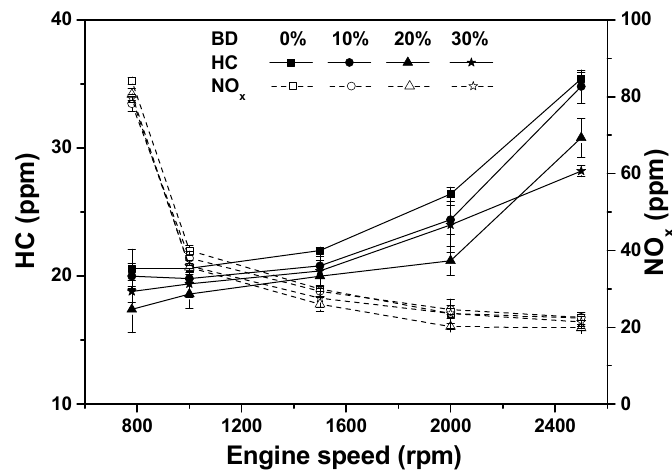
Figure 5. HC and NO x emissions with respect to biodiesel oil ratio and engine speed.